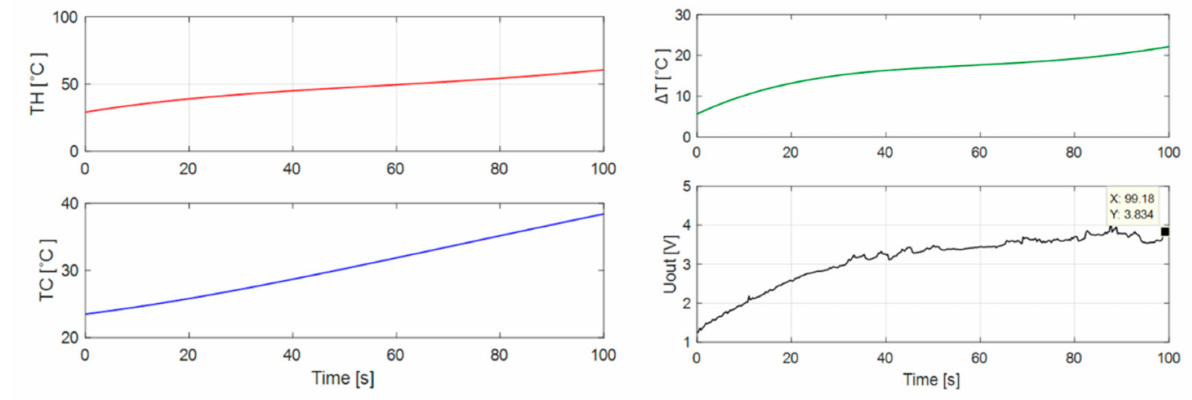
Figure 12. The temperatures and DC/DC converter output voltage curves recorded during 100 s of thermic unsteady state for resistive load R o = 50 Ω